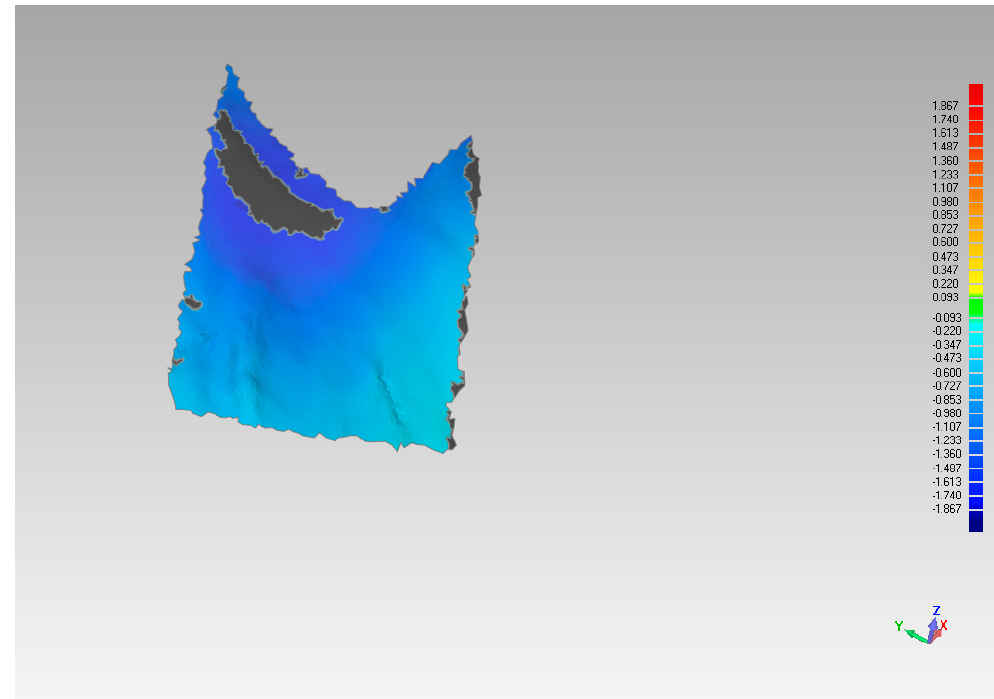
Figure 5. Analysis of palatal variation in the pre-implant placement model compared to pre-extraction model.